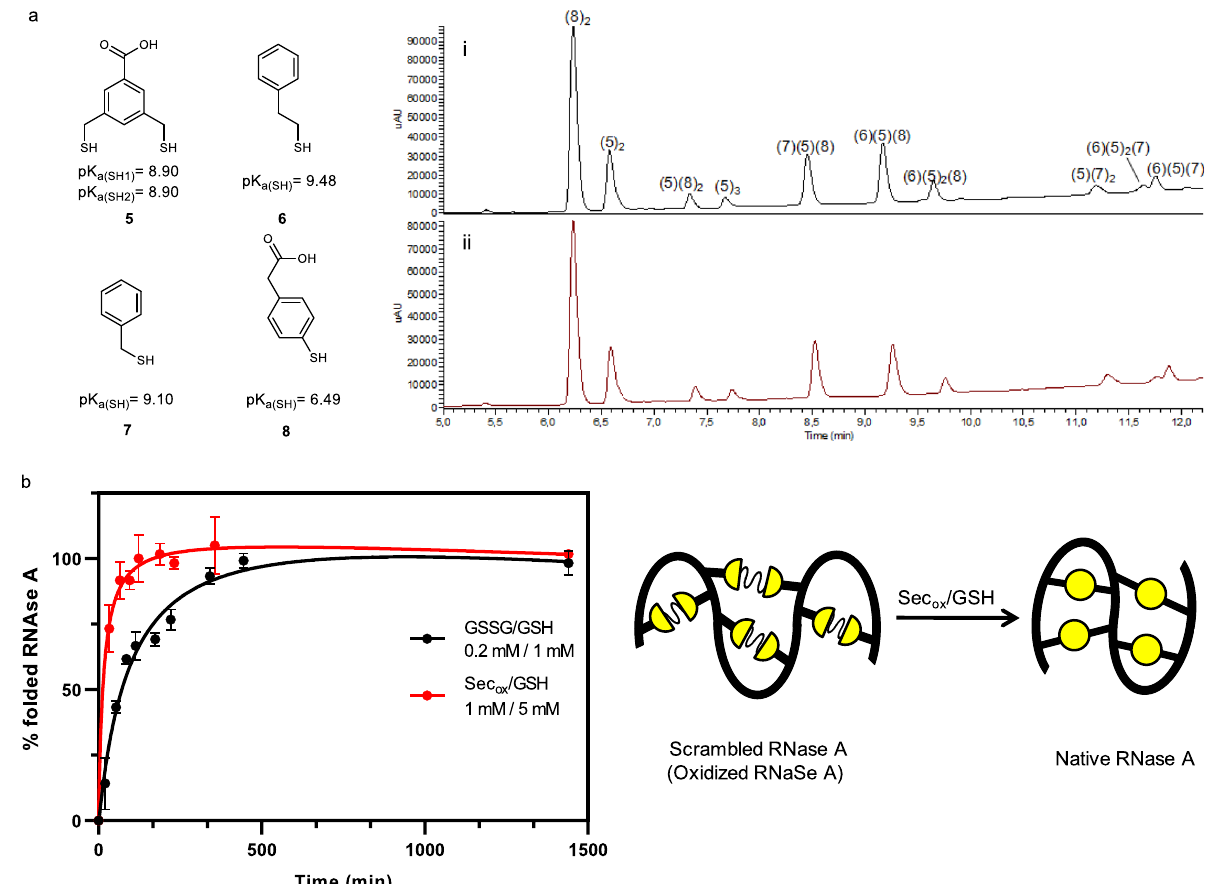
Fig. 7 Selenocystine applied to a slow DCL and a protein refolding. a Slow thiol/disul fi de exchange. Building block 5 (52,3 μ M) and building blocks ( 6 – 8 ) at 104.6 μ M concentration each. Tris buffer 20 mM pH 7.8 at 20% (v/v) DMSO and 6 °C. (i) 0% mol Sec ox as control after 192 h, (ii) 5% mol Sec ox (18.3 μ M) after 60 h. Relative peak areas (RPAs) of the DCLs, see Supplementary Fig. 36 and Supplementary Table 2. p K a values estimated from Schrödinger Release 2020-2 54 . See Supplementary Fig. 2 for p K a calculations. b Kinetics for scrambled RNase A folding at pH 7.8 and room temperature. Yellow circles symbolize disul fi de bonds. General conditions: scrambled RNase A (5 μ M), tris buffer 100 mM, pH 7.8, 2 mM EDTA. 0.2 mM GSSG/1 mM GSH (black dots), 1 mM Sec ox /5 mM GSH (red dots). Mean ± SD from two independent experiments. Source data are provided as Source Data fi